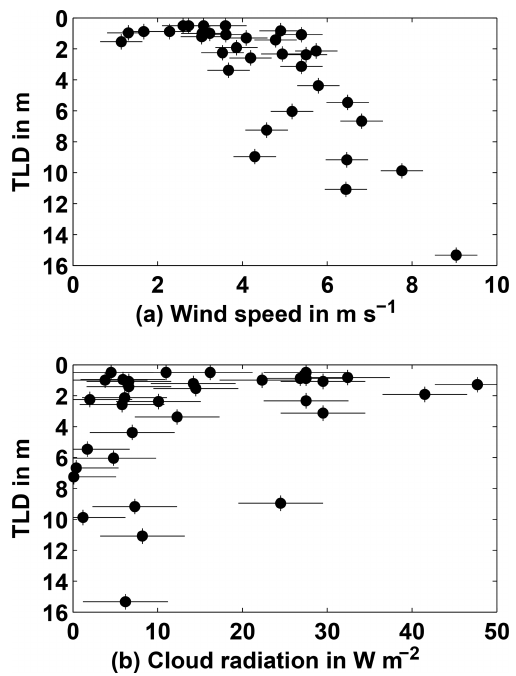
Figure 8. Influence of wind speed (a) and cloud radiation (b) on nighttime near-surface stratification. Night TLD is the night average from glider hydrographic time series (Fig. 7). Wind speed is the night rms average of ship wind from collocated positions (distance ≤ 0 . 3 ◦ lat. and long.), converted to 10m wind under non-neutral conditions using the COARE algorithm. Cloud radiation is the night average of long wave radiation minus clear-sky long wave